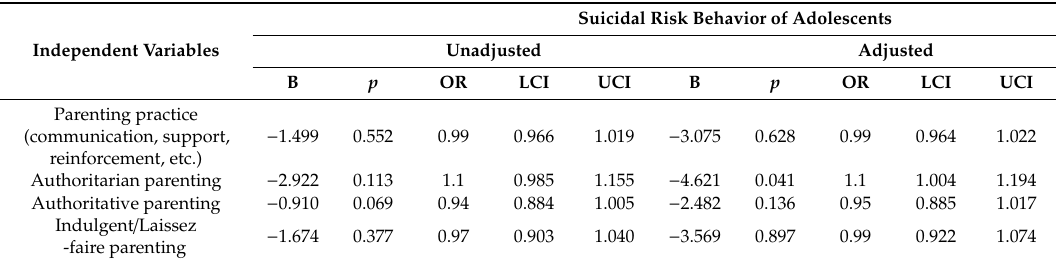
Suicidal Risk Behavior of Adolescents